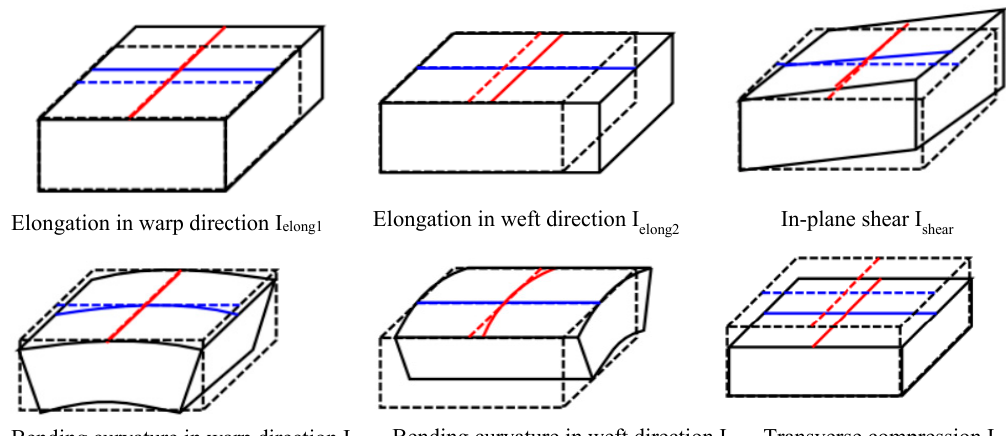
Figure 2. Deformation modes for woven reinforcement within a hyperelastic framework.